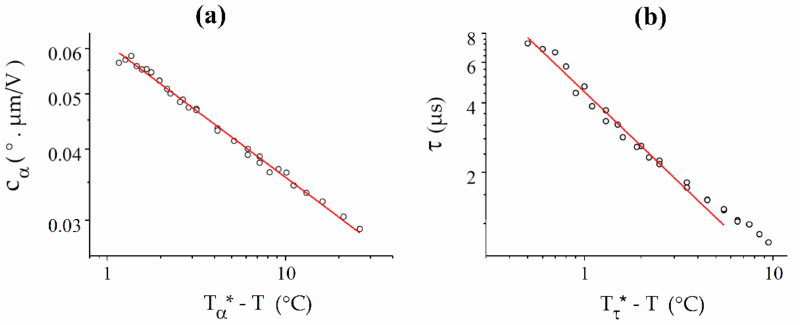
Figure 14. Best fits (solid red lines) of c α ( T ) and τ ( T ) with power laws for BNA76: ( a ) For c α ( T ) , the fit c α ( T ) ∝ ( T α * − T ) − β α is very good over the entire 25 ◦ C range under study, with T α * = 121.17 ◦ C and β α = 0.23; ( b ) The power law τ ( T ) ∝ ( T τ * − T ) − β τ , with T τ * = 120.50 ◦ C and β τ = 0.78, fits the curve well only in a range of about 6 ◦